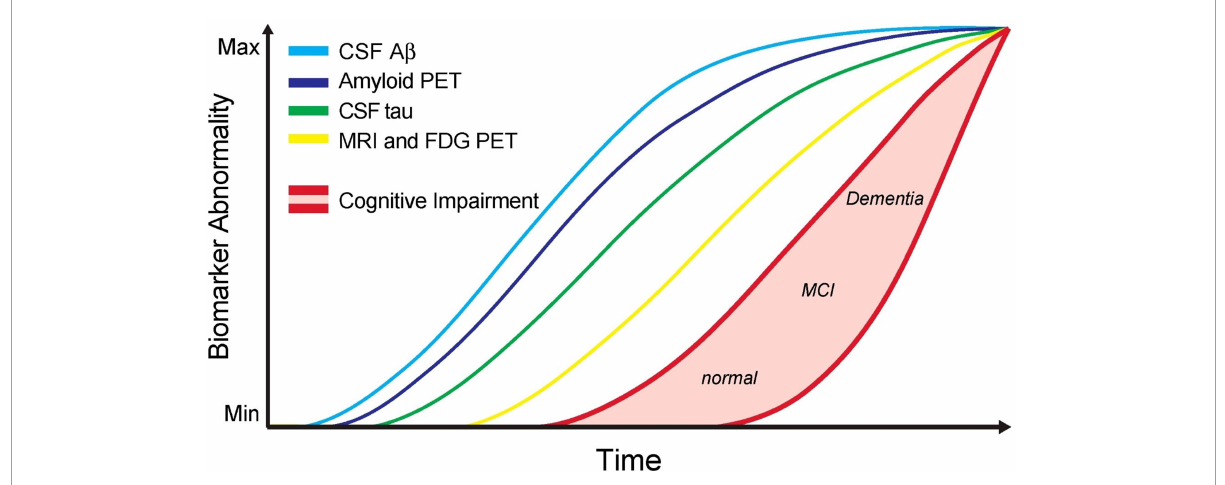
FIGURE1 Updated model of the jack graph. In this new model, the ordering of some biomarkers has been altered to reflect a new understanding, and the horizontal axis now depicts time. As all curves converge in the top right of the graph, this indicates the point of maximum abnormality, and the red shaded area indicates a cognitive response to this abnormality. Cerebrospinal fluid (CSF) A β 42 and amyloid-positron emission tomography (PET) measure amyloid- β burden. CSF tau to measure tau burden. MRI + FDG PET to measure neurodegeneration. Cognitive impairment with low and high-risk regions. Scale is biomarker abnormality, not concentration increase. Figure from Pawlowski et al. (2017).